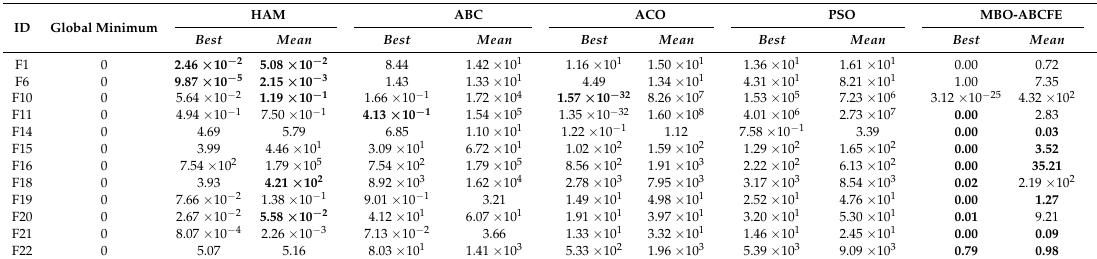
Table 5. Scientific results of HAM, ABC, ACO, PSO, and MBO-ABCFE on 20-dimensional problems averaged over 100